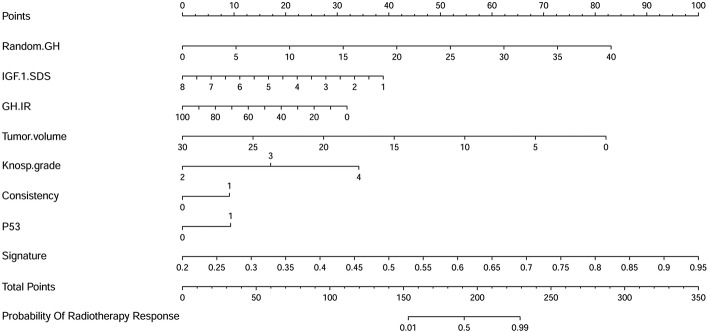
A nomogram derived from the radiomics model. This nomogram is used based on the value of the patient's eight risk factors, including radiomics signature, random GH, IGF-1 standard deviation score (SDS), GH inhibition ratio (IR), tumor volume, Knosp grade, tumor consistency, and P53 value. As shown in our previous research (49), draw a vertical line from the corresponding axis of each factor until it reaches the first “Points” line. Next, summarize the points of all risk factors, then draw a vertical line that falls vertically from the “Total Points” axis until it reaches the last axis to determine the radiotherapeutic response.